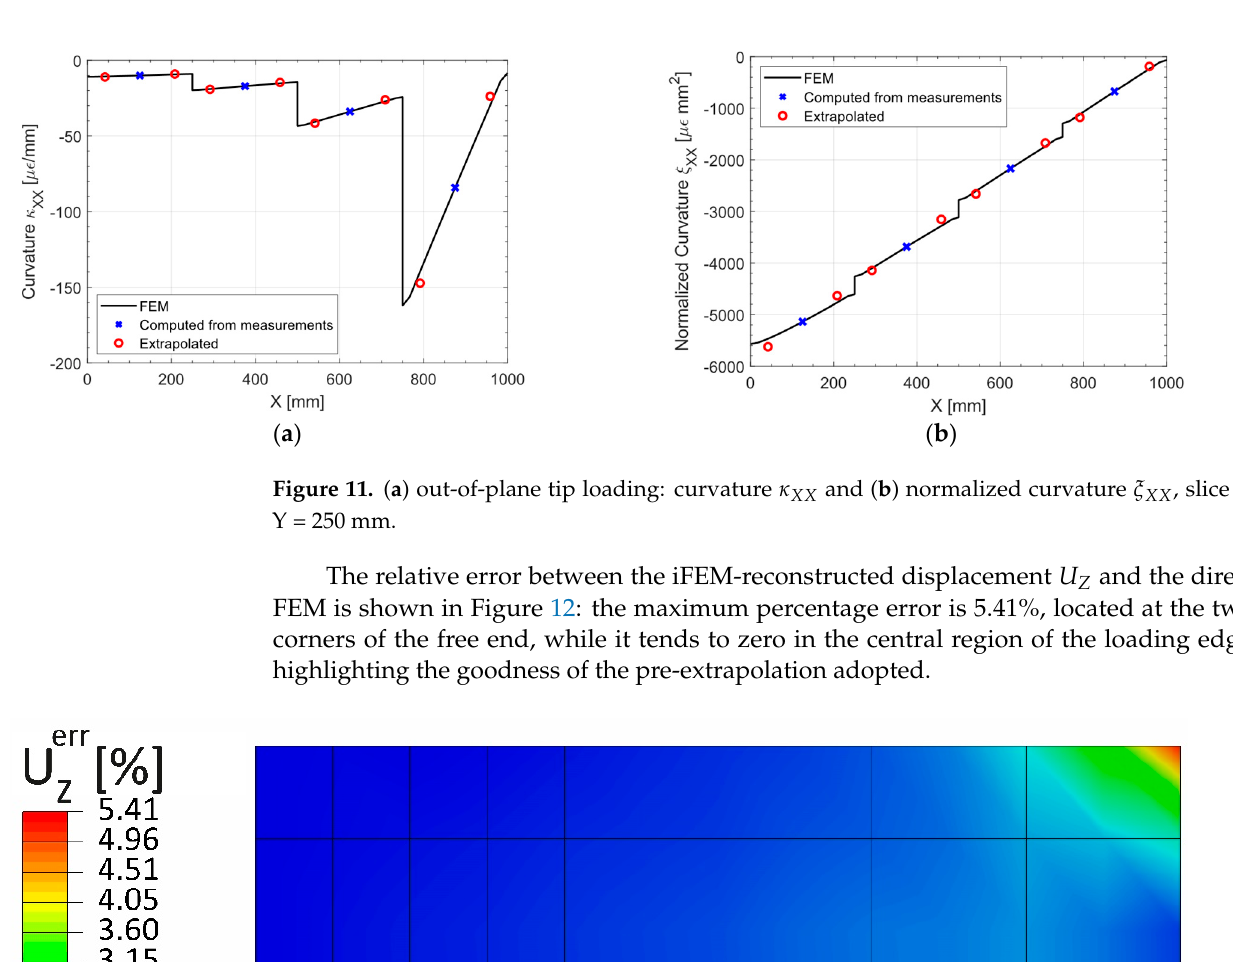
Figure 12 . Out-of-plane tip loading: percentage error of the 𝑈 (cid:3027) displacement.